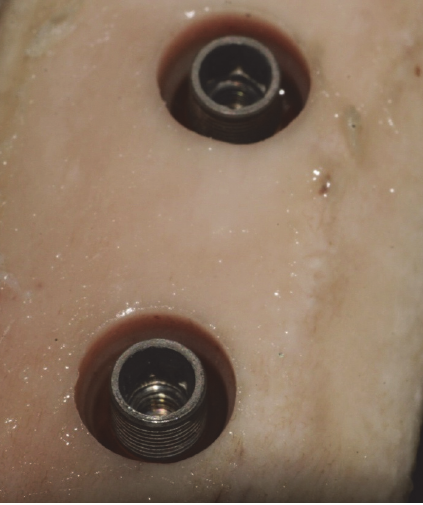
Figure 2: Preparation of circumferential bone defect and implant